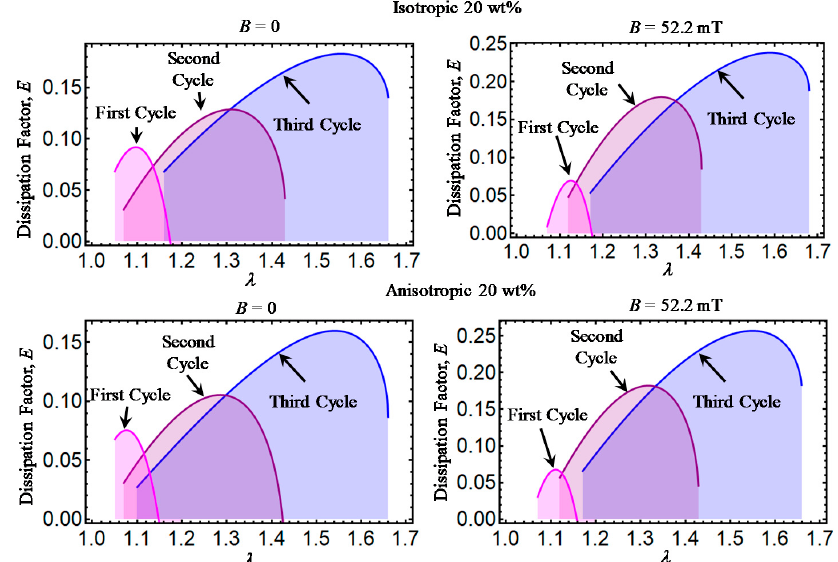
Figure 6. Dissipation factor curves for magnetorheological material samples made with a concentration of 20 wt% of CIPs. A high value of E indicates that the energy loss per loading–unloading cycle is small. The higher the E, the lower the stress-softening and residual strain effects related to the molecular material damage. Also, notice that the area under the curve indicates the material capacity to dissipate energy per loading–unloading cycle.